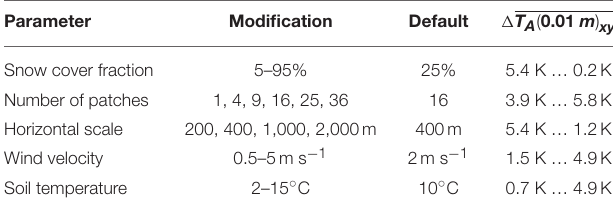
TABLE 1 | Parameter of the sensitivity analysis and 1 T A (0.01 m ) xy (Equation 2; averaged over snow covered